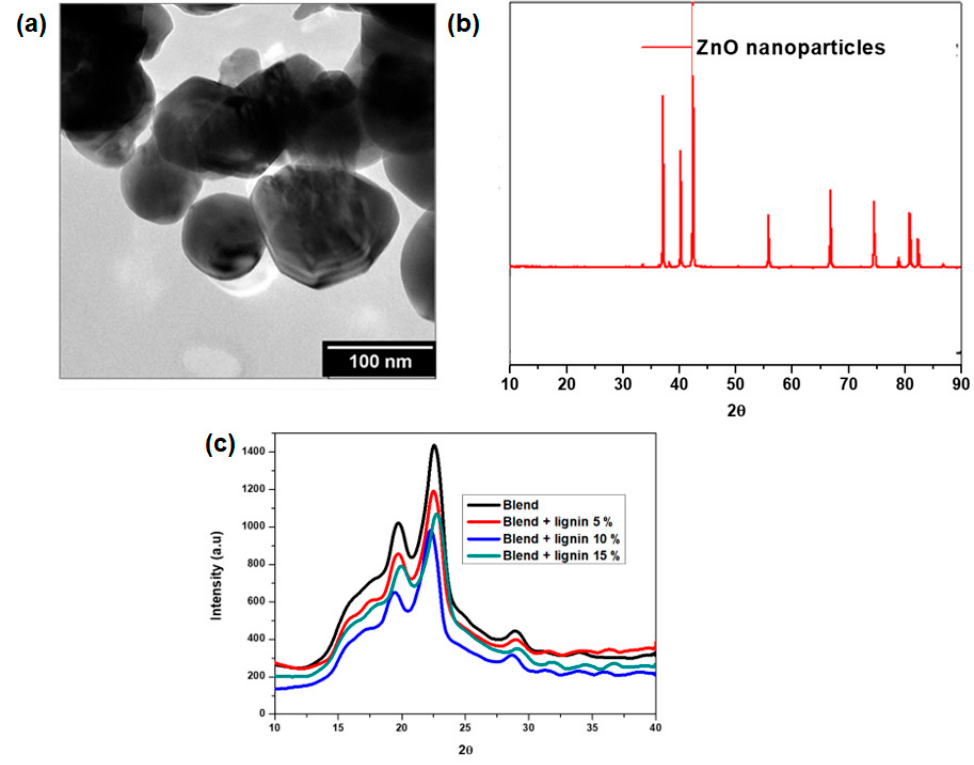
Figure 5. ( a ) TEM image of ZnO nanoparticles, ( b ) XRD profile of ZnO nanoparticles, and ( c ) XRD profiles of biopolymer blend and hybrid composites.